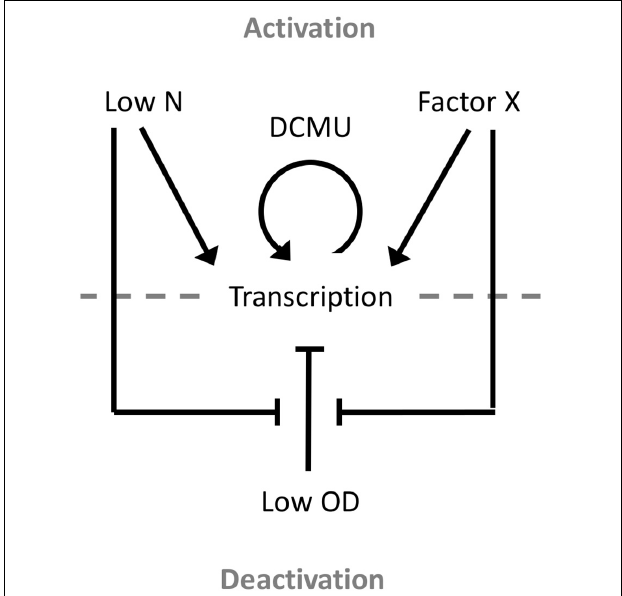
FIGURE 10 | Model of the environmental regulation of PndbA600. Promoter activation and, thus, transcription occur in response to either low N or Factor X of the spent stationary phase medium. Once activated, promoter activity can be further increased using the photosynthesis-specific inhibitor DCMU. Promoter deactivation requires low culture density, sufficient N supply, and the absence of Factor